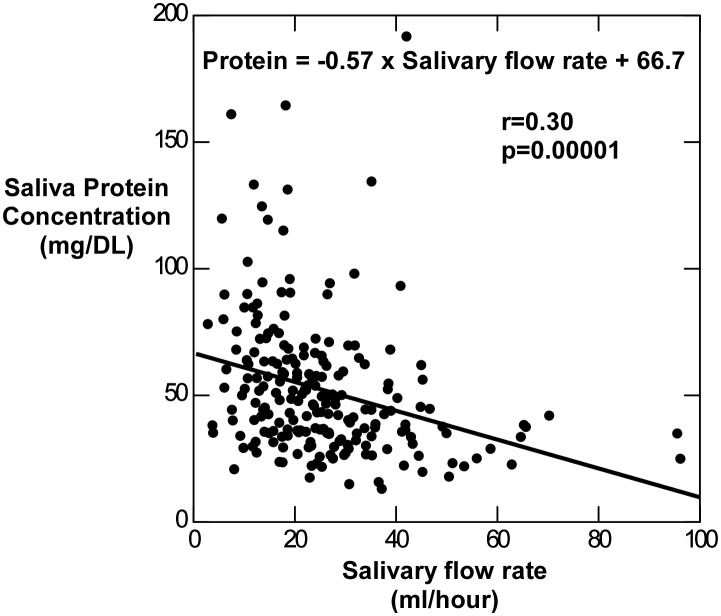
Total salivary protein concentration and salivary flow rate.In the subset of 213 samples from children measured for total salivary protein, protein content significantly declined with increased salivary flow rate.